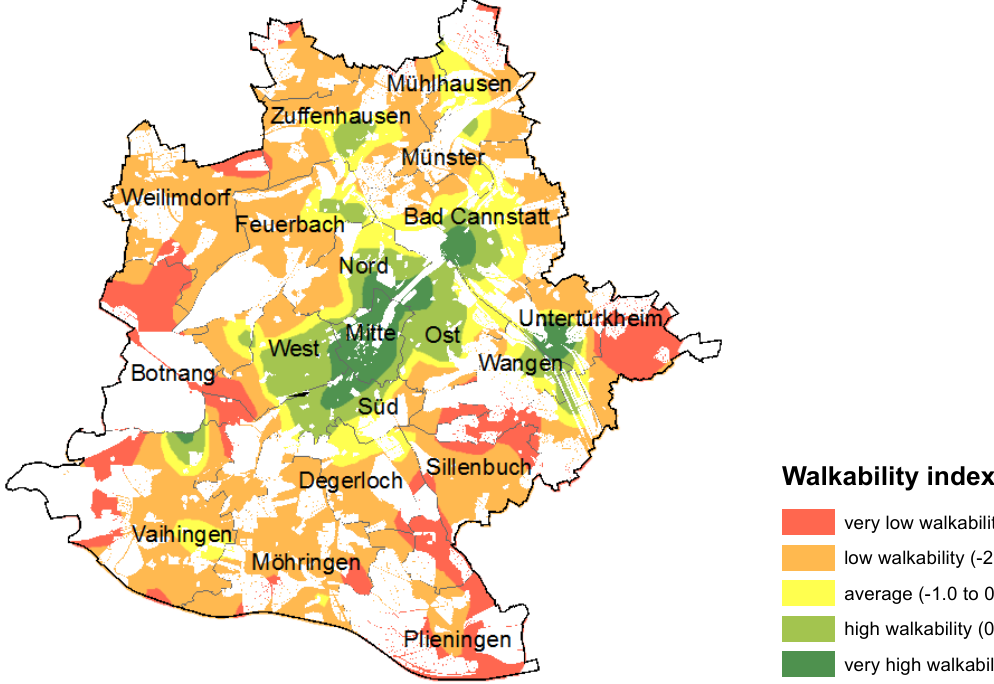
Figure 1. Walkability index (WAI) for the City of